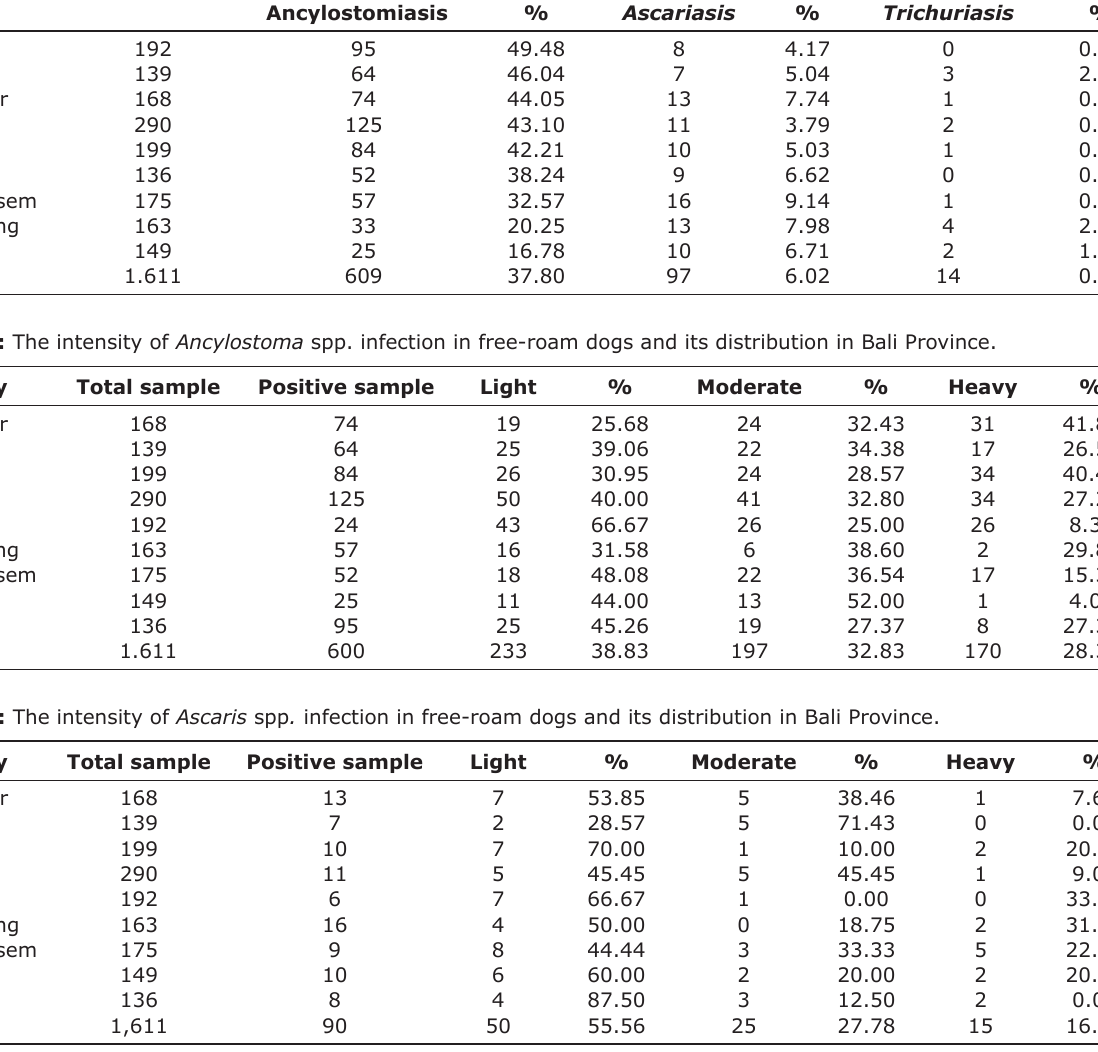
Table-2: The prevalence of identified worms infection in free roam dogs and its distribution in Bali Province. Regency